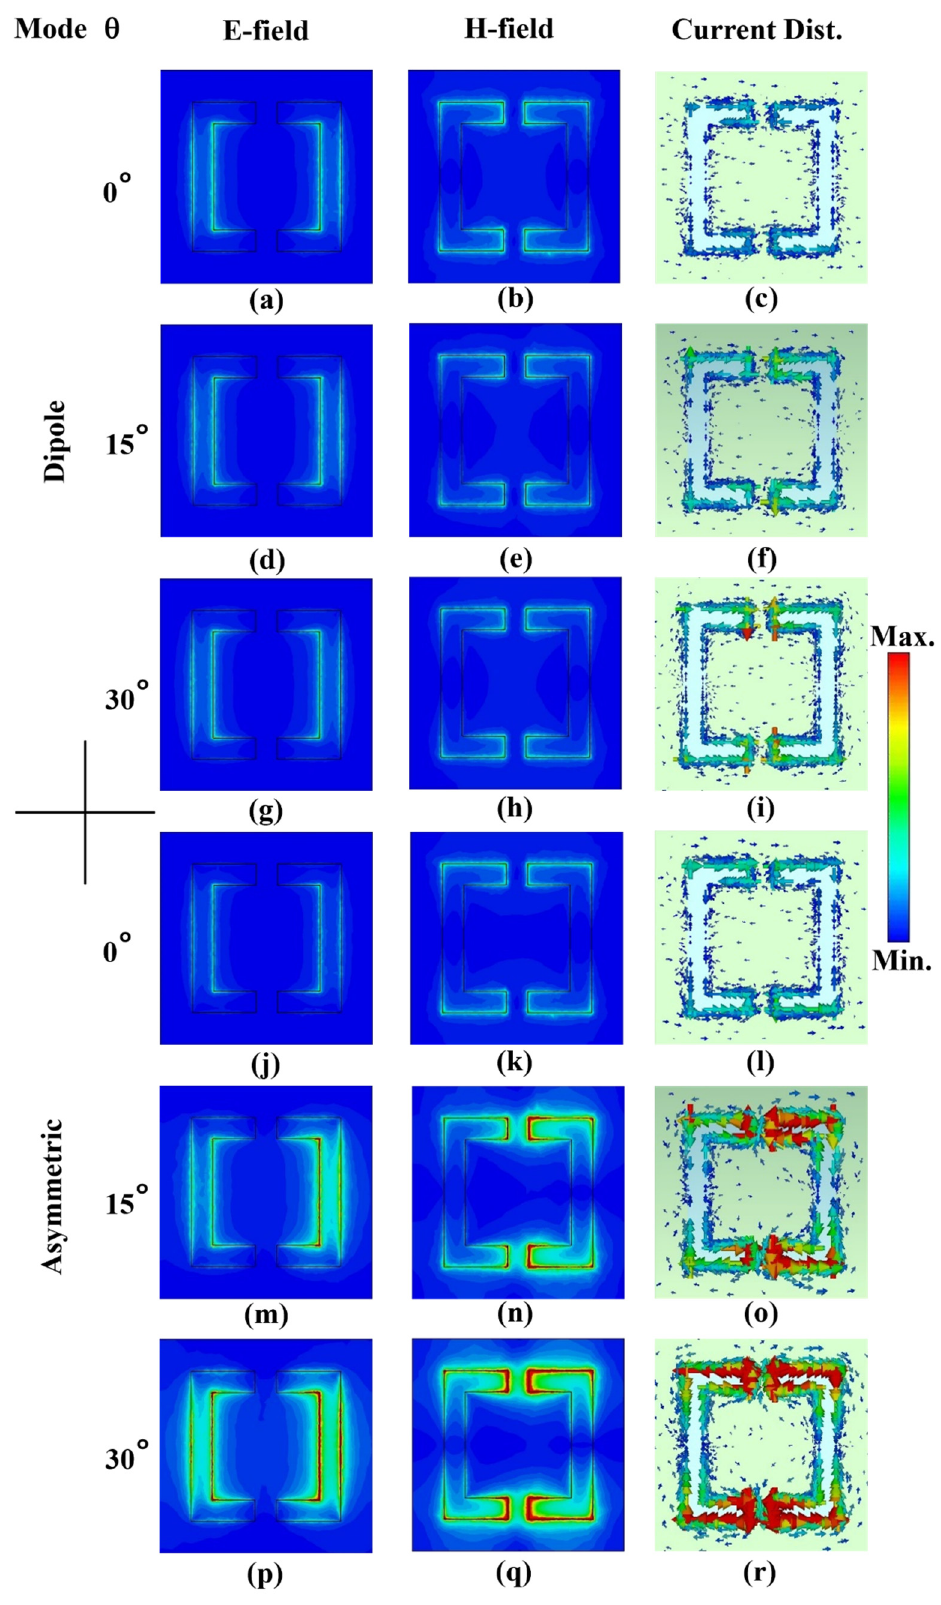
Figure 4. Spatial distribution of ( a , d , g , j , m , p ) electric, ( b , e , h , k , n , q ) magnetic field, and ( c , f , i , l , o , r ) current distribution at the dipole frequency (rows 1–3) and the asymmetric resonance frequency (rows 4–6) for an incident angle of 0°, 15°, and 30°.